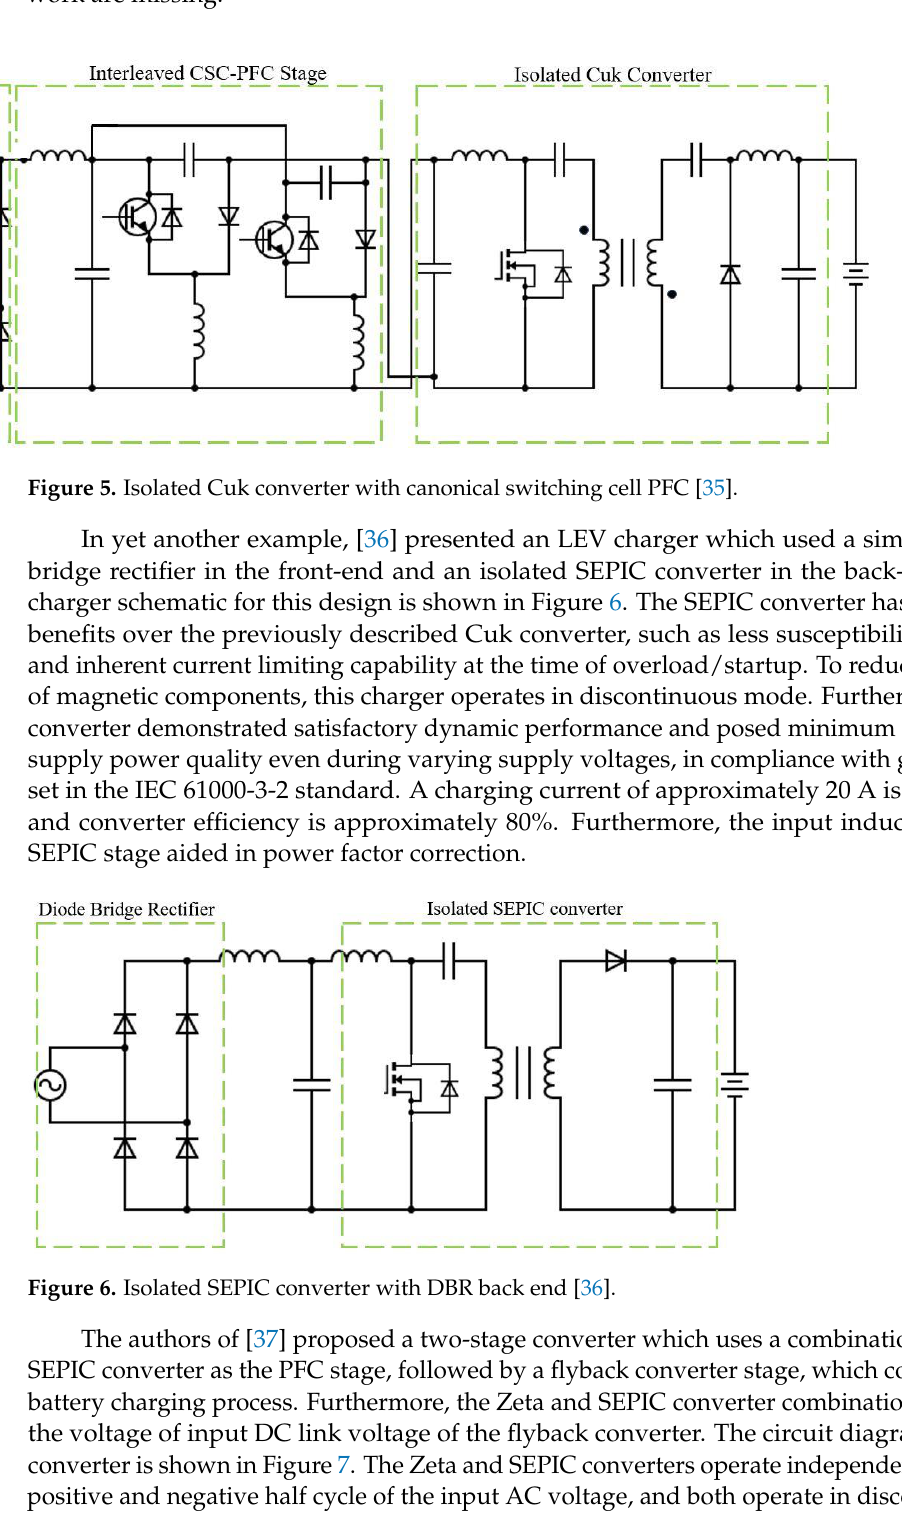
Figure 6. Isolated SEPIC converter with DBR back end [36].